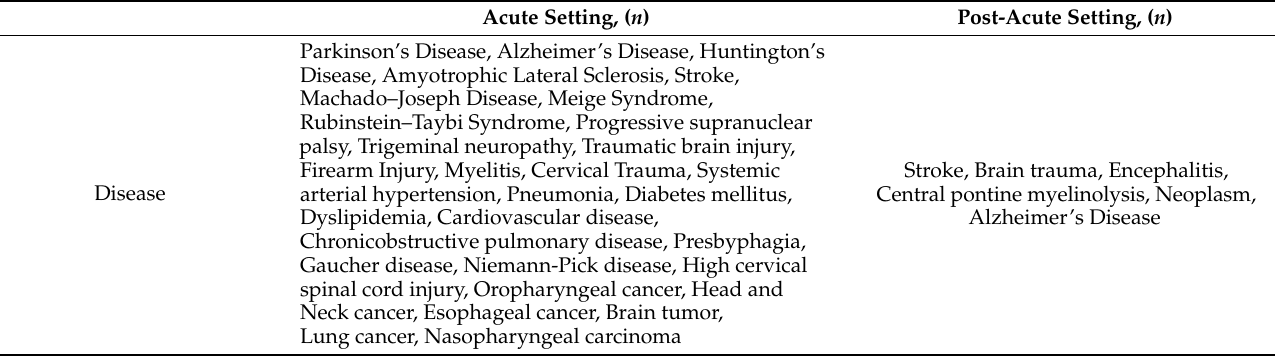
Table 3. Nutritional assessment items used for adult patients with dysphagia in acute and post-acute settings.